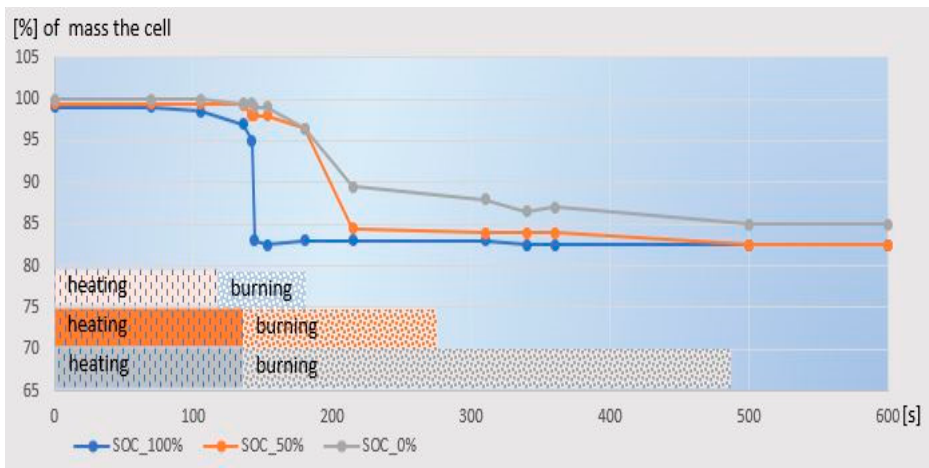
Figure 1. Loss of mass in per cent during battery combustion in various charge states (Own elaboration on the basis of the data from [18]).